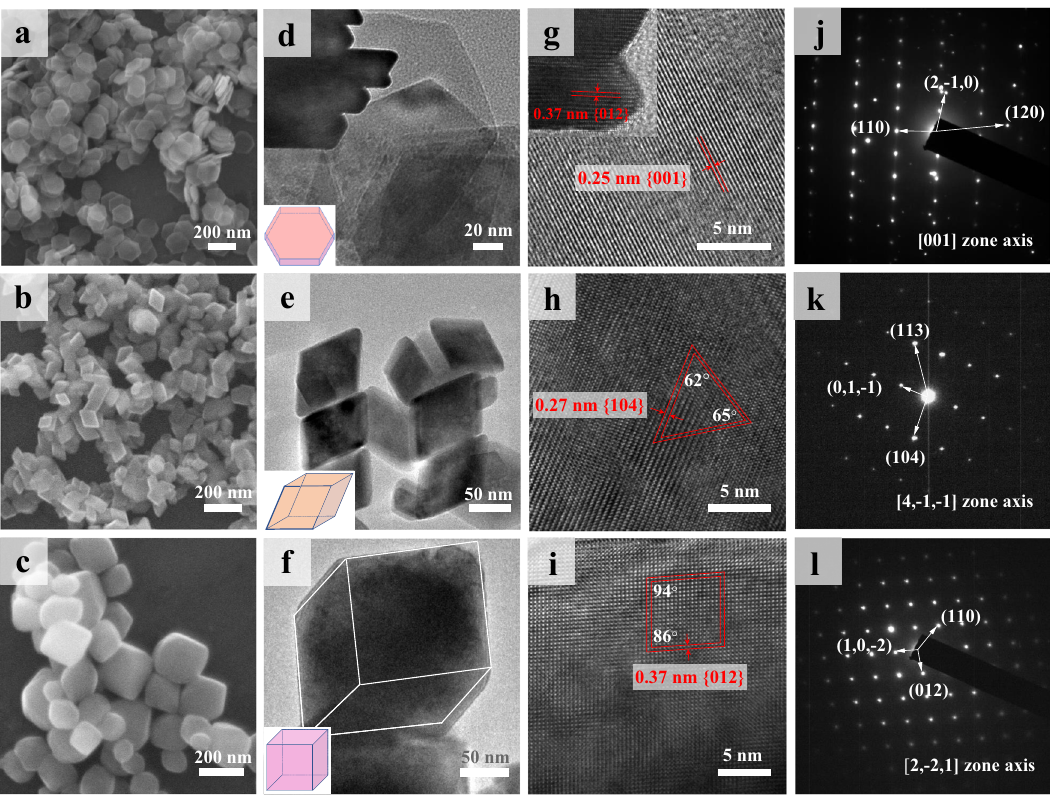
Fig. 1 | Morphologies and facet constitutions. SEM images ( a – c ), high- magni fi cation TEM images ( d – f ), HRTEM images ( g – i ) and corresponding SAED patterns( j – l )of hematite nanoplate(HNP)( a , d , g , j